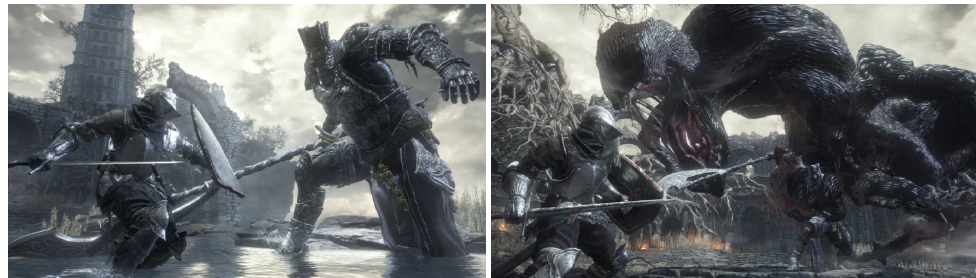
Figure 1. The Knight class warrior battling with Iudex Gundyr in the first phase ( left ) and in the second phase ( right )